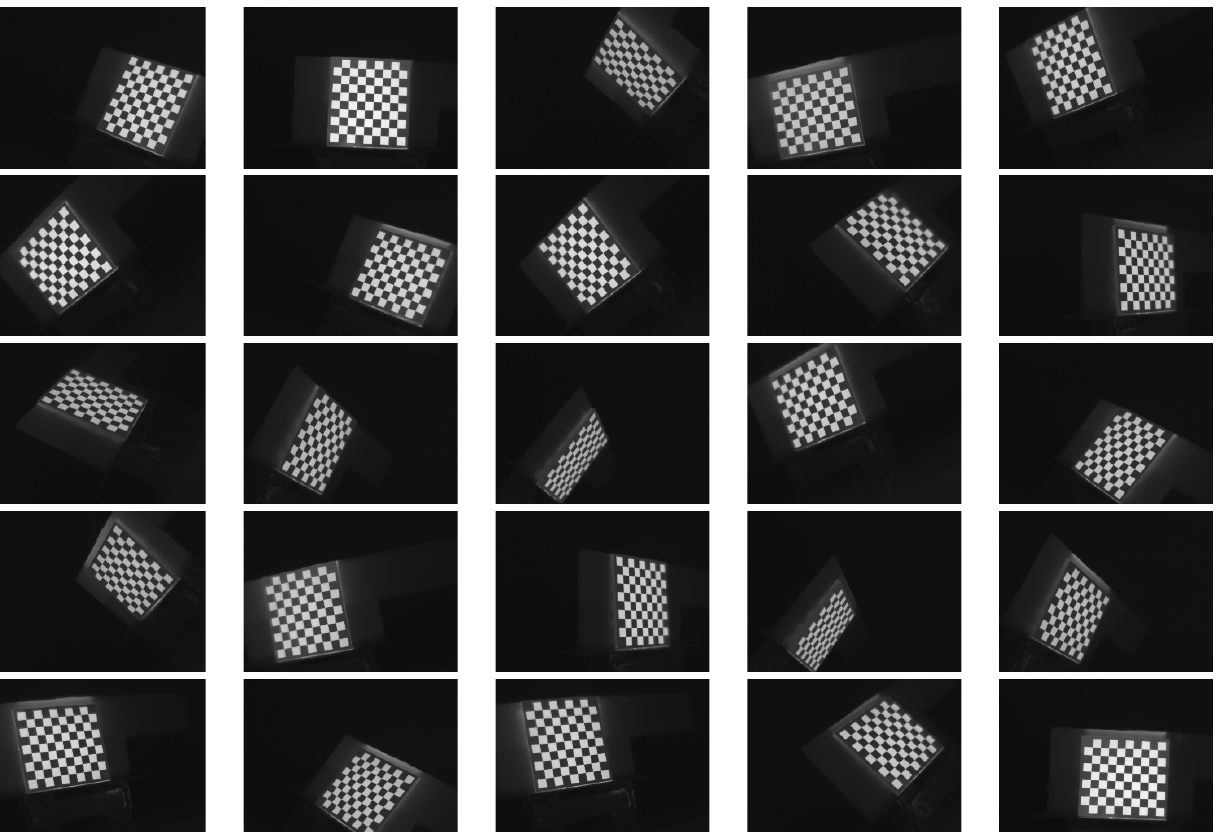
Figure 7. Thermal images of the laser-engraved checkerboard pattern viewed at random orientations for the IR camera geometric calibration.